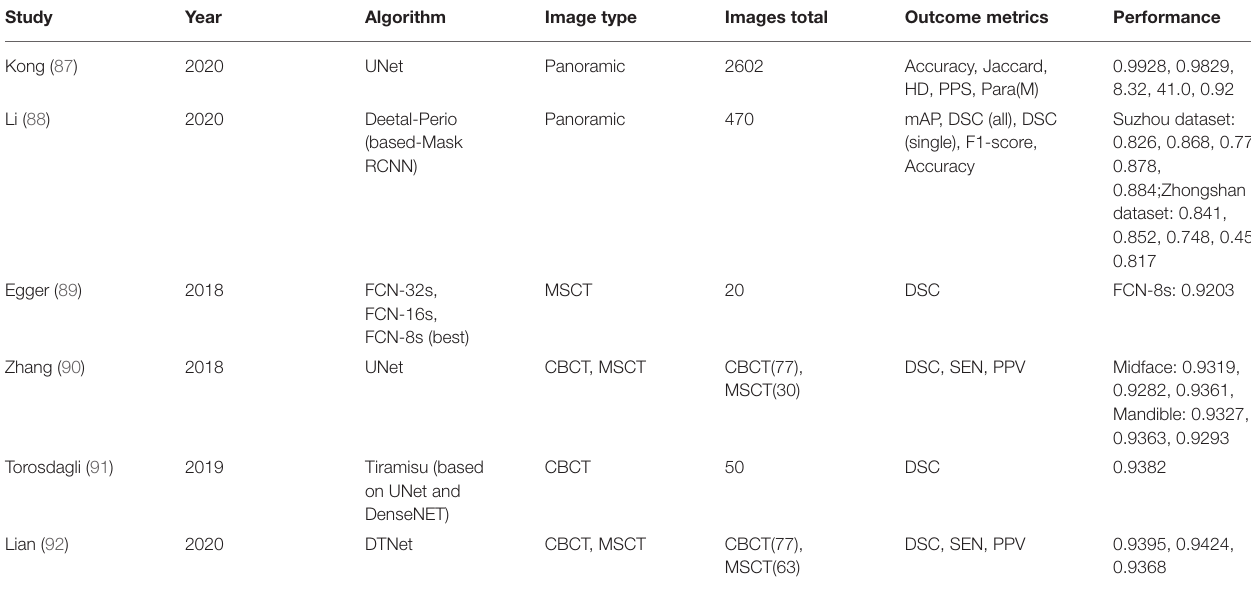
TABLE 6 | Semantic segmentation in the jaw.